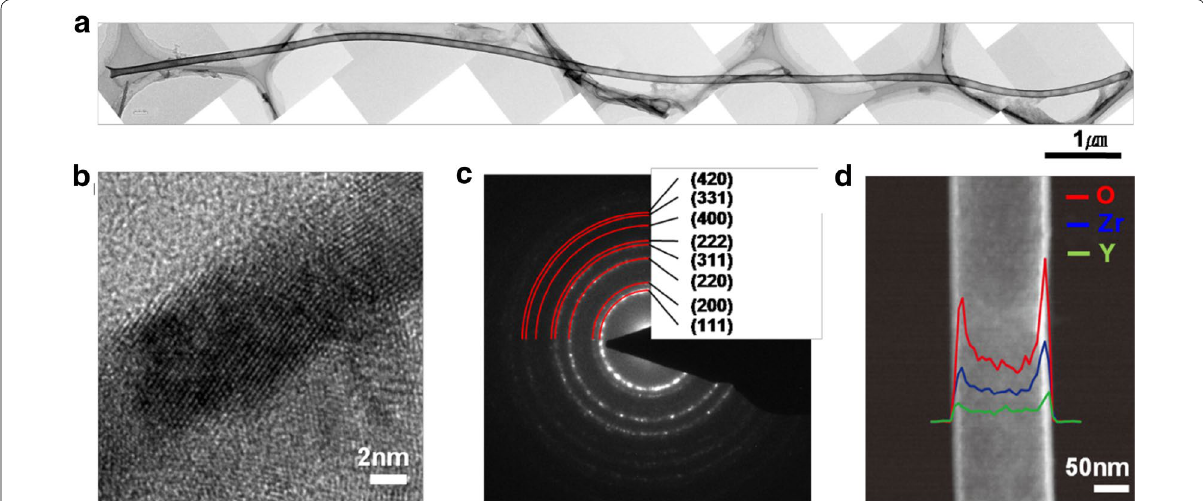
Fig. 1 TEM micrographs of YSZ NTs grown by repeating a full ALD cycle consisting of 1 yttria and 7 zirconia sub-cycles. a Low-magnification image, exhibiting a high aspect-ratio of over 120, 110 nm in diameter, and 14 μm in length. Note that one distal end is open. b The lattice image, showing that the YSZ-NTs are formed with well-crystallized nanometer sized grains of less than 10 nm in diameter, as grown. c The selected electron area dif- fraction (SEAD) patterns are consistent with cubic phase of zirconia (JCPDS #30-1468). d EDS elemental line profiles across a YSZ NT also confirmed Y-doped ZrO